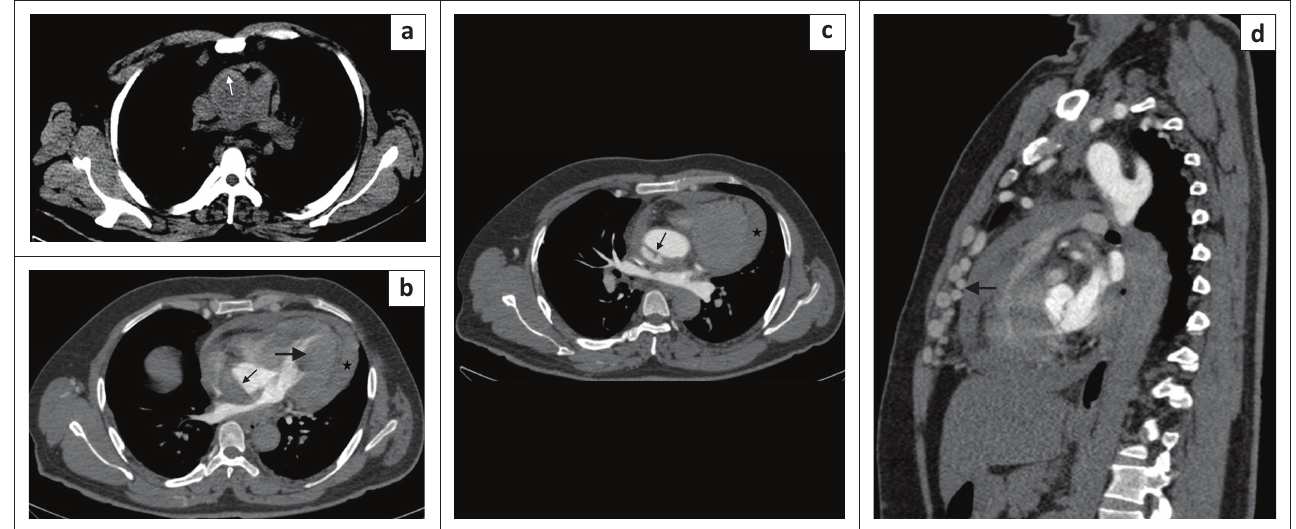
FIGURE 8: Coarctation of the aorta with a type A intramural haematoma (IMH) and aortic dissection. (a) Unenhanced axial computed tomography (CT) scan showing circumferential hyperdense thickening of the ascending aorta (arrow); (b) Contrast-enhanced axial CT showing crescentic non-enhancing hypodense area (thin arrow) representing IMH with haemopericardium ( * ) and concentric left ventricular hypertrophy (thick arrow); (c) Contrast-enhanced CT scan showing the displaced intimal flap (arrow) and haemopericardium ( * ). (d) Sudden narrowing of the aorta (arrow) distal to origin of the left subclavian artery on sagittal contrast-enhanced images. Multiple collaterals (thick arrow) along the anterior chest wall.